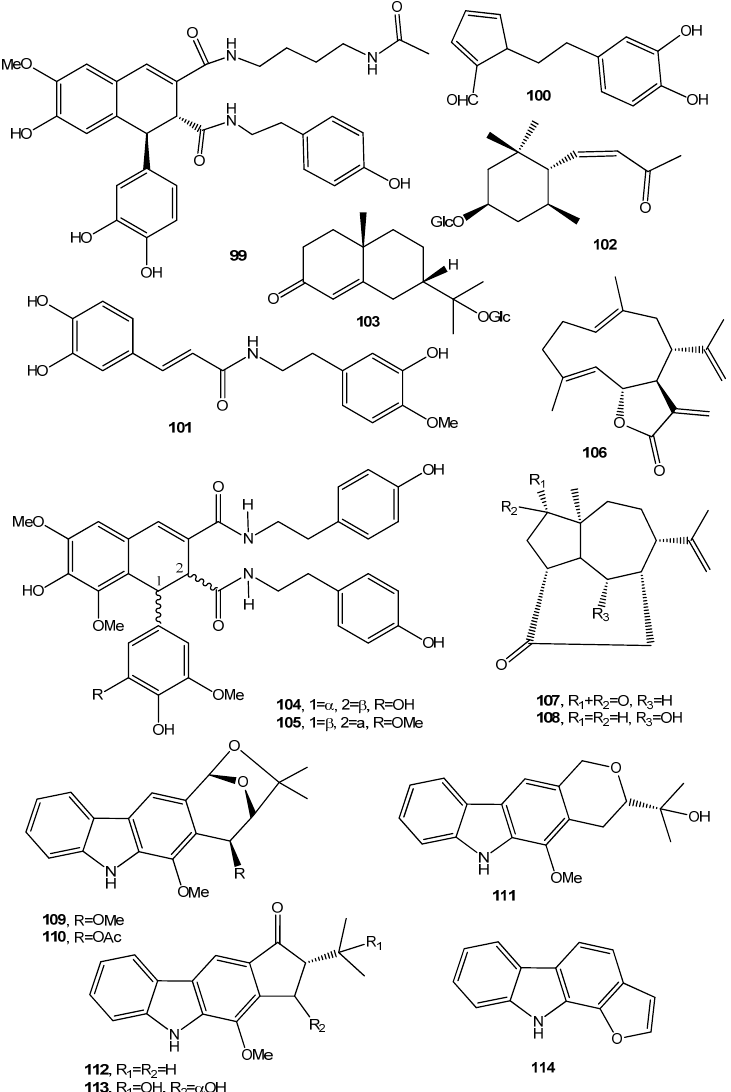
Figure 8. The structures of compounds 99 – 114 . NTCT, NCCT, NTFT and NCFT were isolated together with 13 megastigmanes, including a new megastigmane, nelumnucifoside A ( 102 , Figure 8), and a new eudes- mane sesquiterpene, nelumnucifoside B ( 103 , Figure 8), as well as 8 alkaloids and 11 flavonoids from Nelumbo nucifera Gaertn. (Nymphaeaceae) [88]. This is a peren- nial aquatic herb commonly called lotus. This plant is widely diffused in Eastern Asia and used for food and medicine for a long time. The fruits, seeds, roots and leaves of N. nucifera are edible and have been not only used as food for a long time, but also used as antifebrile, sedative, antibacterial, antidiarrheal and hemostatic agents in folk medicine [89]. The other known compounds were identified as ( E )-3-hydroxymegastigm-7-en-9-one, ( − )-boscialin, (+)-dehydrovomifoliol, vomifoliol, 3-oxo-retro- α -ionol I, byzantionoside A, 5,6-epoxy-3-hydroxy-7-megastigmen-9-one, annuionone D, icariside B 2 , grasshopper ke- tone, 3 S ,5 R -dihydroxy-6 S ,7-megastigmadien-9-one, (+)-epiloliolide, (6 R ,6a R )-roe-merine- N β -oxide, liriodenine, pronuciferin, oleracein E, quercetin, kaempherol, luteolin, quercetin 3- O -glucopyranoside, kaempherol 3- O -glucopyranoside, chrysoeriol 7- O -glucopyranoside, taxifolin, epitaxifolin, 5,7,3 (cid:48) ,5 (cid:48) -tetrahydroxyflavanone, ( − )-catechin and elephantorrhizol. NTCT and NCFT inhibited pancreatic lipase, while (6 R ,6a R )-roemerine- N β -oxide